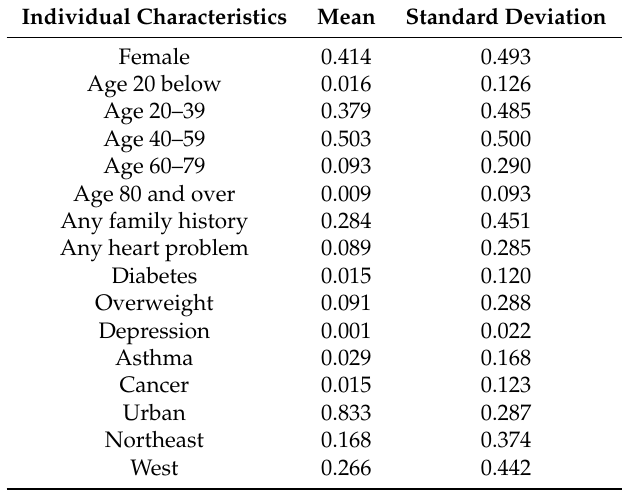
Table 2. Means and standard deviations of individual and area-level